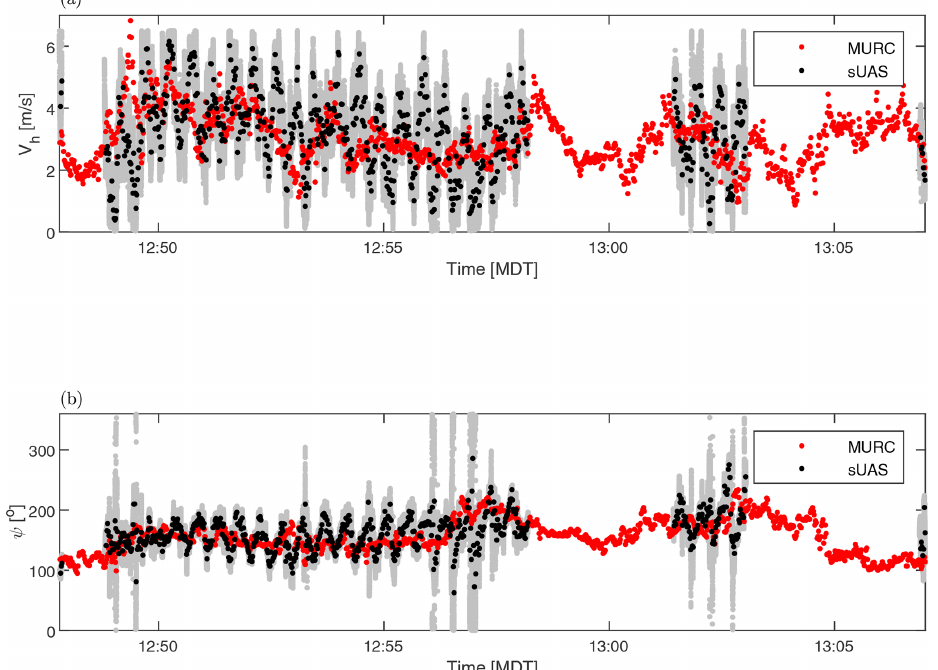
Figure 1. Comparison between uncorrected (a) horizontal wind speed and (b) wind direction measured by the sUAS to the reference signal measured by MURC. Gray lines indicate full signal from the sUAS, whereas black lines indicate the same signal downsampled to the same data rate as that of the MURC by plotting every 200th data point.